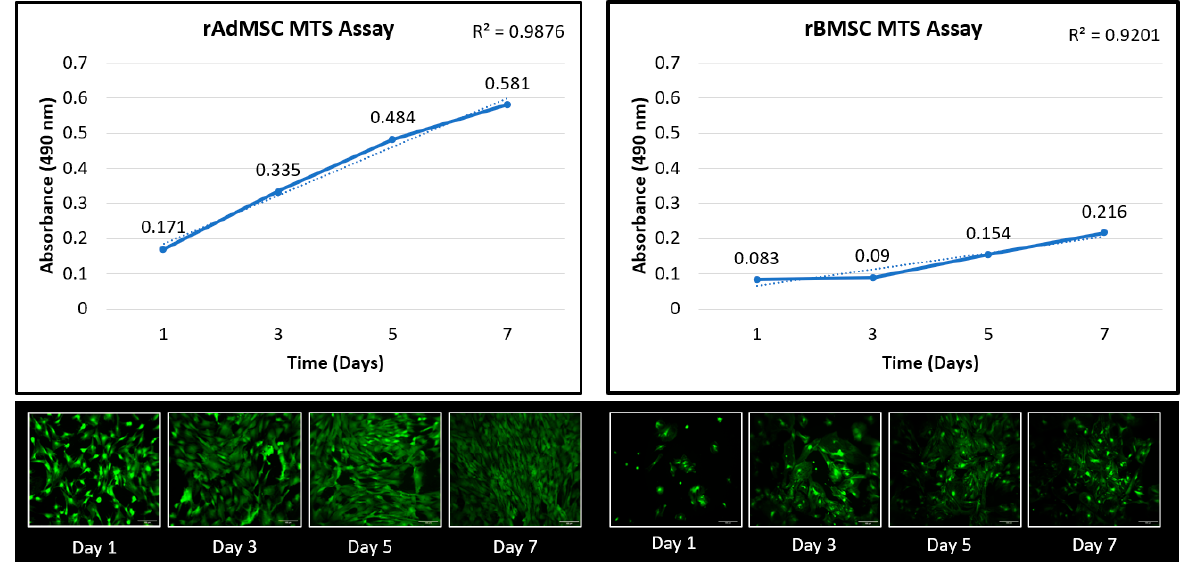
Figure 2. Proliferation and viability assays of rat adipose-derived and bone-marrow-derived mes- enchymal stem cells. The solid line represents average absorbance at 490 nm at Days 1, 3, 5, and 7, and the dashed line represents the linear trendline for the respective data; the coefficients of determination (R 2 values) of linear regression are reported in the upper right corner of each graph. Representative confocal images of calcein AM stained cells at each timepoint are included below the respective cell lineage’s graph. Scale bar = 100 μ m.